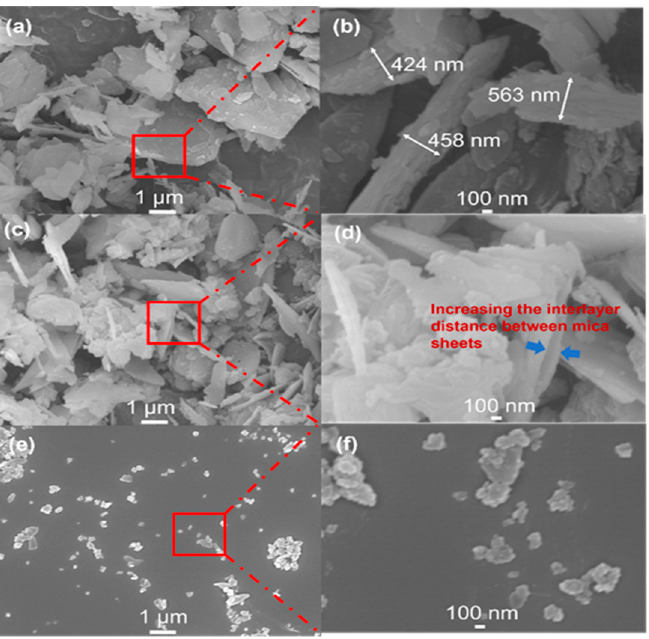
Figure 2. SEM images of ( a ) natural bulk mica and ( b ) its magni fi cation image, ( c ) expanded mica, and ( d ) its magni fi cation image, and ( e ) eMica nanosheets, and ( f ) its magni fi cation